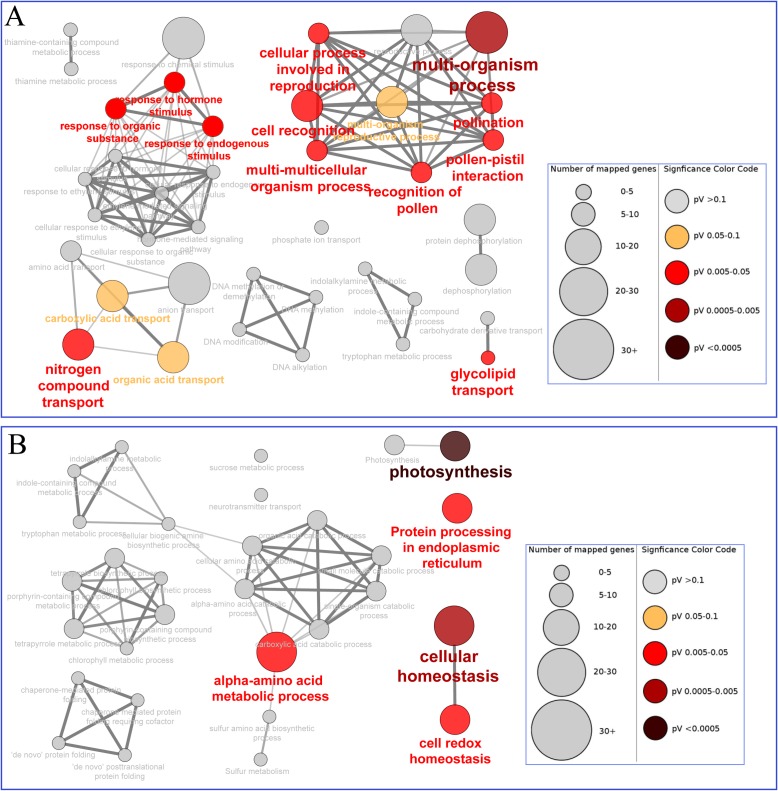
GO enrichment analysis involved in biological processes.Specific up- and downregulated DEGs of FNP plants were analyzed using the Cytoscape plug-in ClueGo + Cluepedia to detect statistically enriched GO categories relative to the ClueGO maize reference genome involved in biological processes (BP). (a) ClueGO plot in GO_BP for specific upregulated genes. (b) ClueGO plot in GO_BP for specific down-regulated genes. Nodes indicate a specific GO term and are clustered based on similarities in their associated proteins. Each node relates to a single GO term and is represented by a specific color according to enrichment significance (pV = p value). Node size represents the number of proteins that were mapped to each category. Edge thickness indicates the calculated kappa score, which is based on the number of proteins that are shared among various terms. Functional groups are indicated by the most significant term relating to the group. Arrows represent positive regulation.